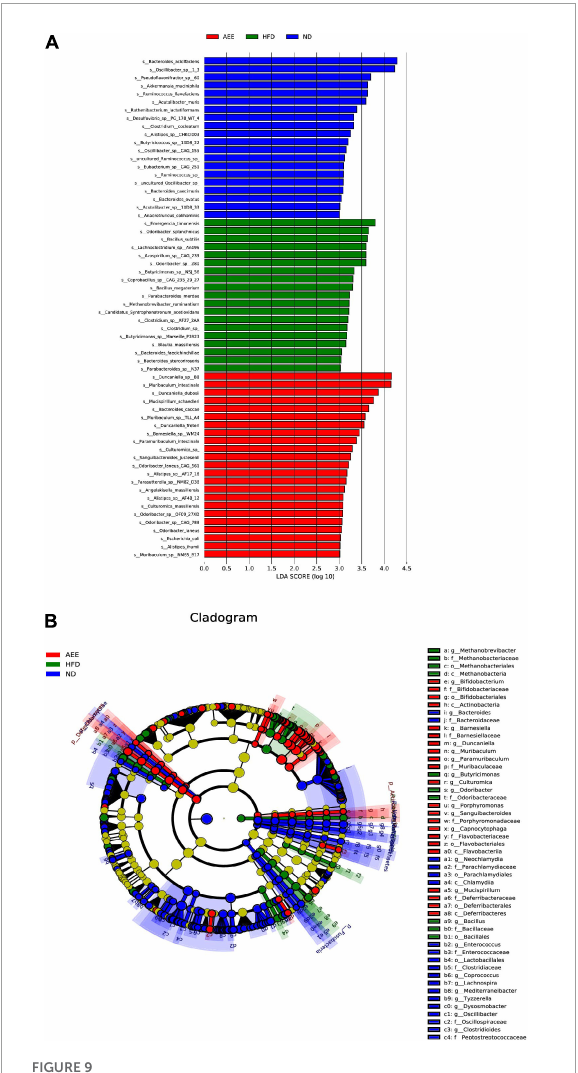
FIGURE9 The analysis of linear discriminant analysis coupled with effect size measurements (LEfSe). (A) The linear discriminant analysis (LDA). Different colors indicated different groups, the blue, green, and red bars indicated species with relatively high abundance in the ND, HFD, and AEE groups, respectively (LDA). (B) Differential species annotation branch diagram. Differential species annotation branch illustration. Different colors indicated different subgroups. The blue, green, and red nodes indicated differentially significant species with relatively high abundance in the ND, HFD, and AEE groups, and the yellow nodes indicated species with no significant difference in the comparison between the two groups (HFD vs. ND; AEE vs. HFD). The node diameter was in direct proportion to the relative abundance. The nodes in each layer represented Phylum, Order, and Species, respectively, from inside to outside. The notes for species markers in each layer represented Phylum, Order, and Species from outside. The lettered species names are shown in the legend on the